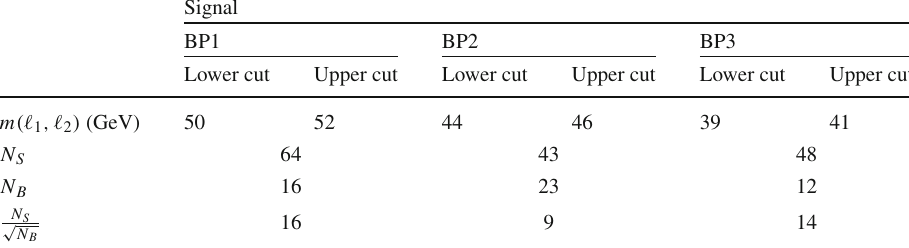
Table 6 Mass window cuts in GeV, the number of signal and background events in the mass window and the